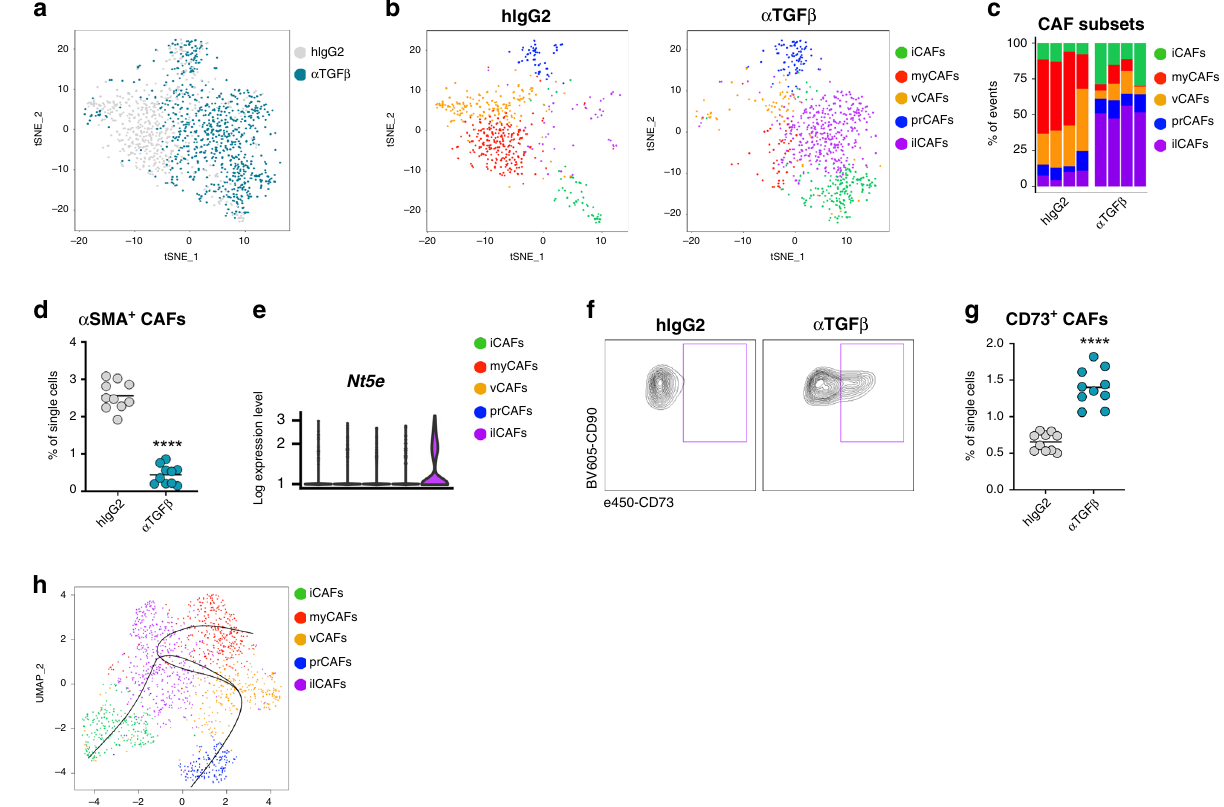
Fig. 4 TGF β -blockade ablates myo fi broblasts and induces expansion of CD73 + CAFs. a Superimposed t-SNE projections of CAF-curated single cell RNAseq data from isotype- and anti-TGF β -treated mice. n = 4 mice per group from 2 independent experiments. b Representative t-SNE plots highlighting CAF clusters in isotype- and anti-TGF β -treated mice. c Frequency of CAF subsets within the overall CAF cluster. Each column represents a mouse. n = 4 mice per group from 2 independent experiments. d Quanti fi cation of CAFs expressing α SMA from dissociated 4T1 tumors of isotype- and anti-TGF β - treated mice by fl ow cytometric analysis. Each dot represents a mouse. Mean is depicted. n = 10 mice per group. Data are representative of four independent experiments. **** p < 0.0001 (unpaired, two-tailed t -test with Welch ’ s correction). e Violin plot depicting expression of Nt5e in ilCAFs. n = 4 mice per group from 2 independent experiments. f Representative fl ow cytometric analysis of CD73 expression on CAFs from dissociated 4T1 tumors from isotype- and anti-TGF β -treated mice. g Quanti fi cation of CAFs expressing CD73 as a frequency of single cells from dissociated 4T1 tumors of isotype- and anti-TGF β -treated mice by fl ow cytometric analysis. Each dot represents a mouse. Mean is depicted. n = 10 mice per group. Data are representative of four independent experiments. **** p < 0.0001 (unpaired, two-tailed t -test with Welch ’ s correction). h Pseudotime analysis overlaid on UMAP projection depicting divergent trajectories among the fi ve CAF subsets. Each dot represents a cell, and each curve represents a